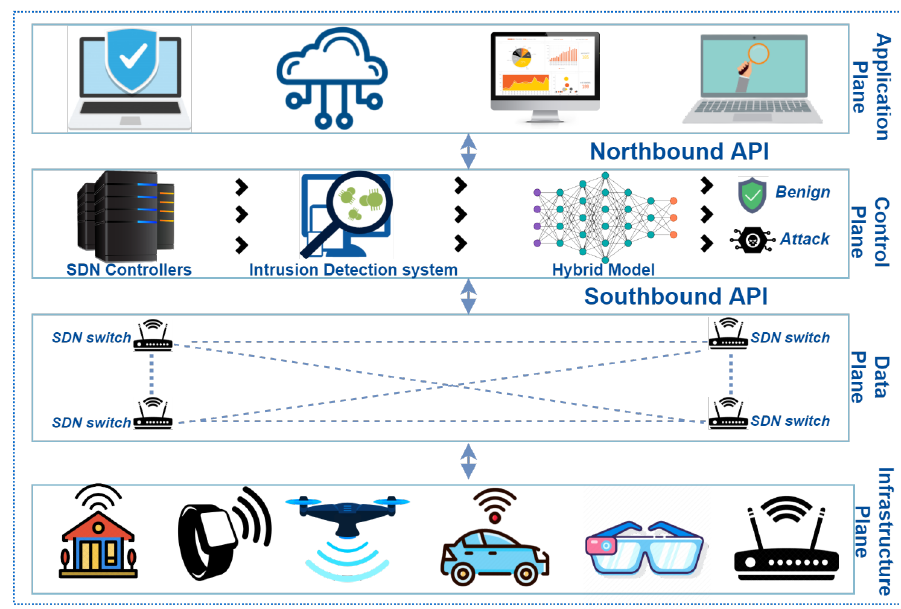
Figure 1. Proposed Network